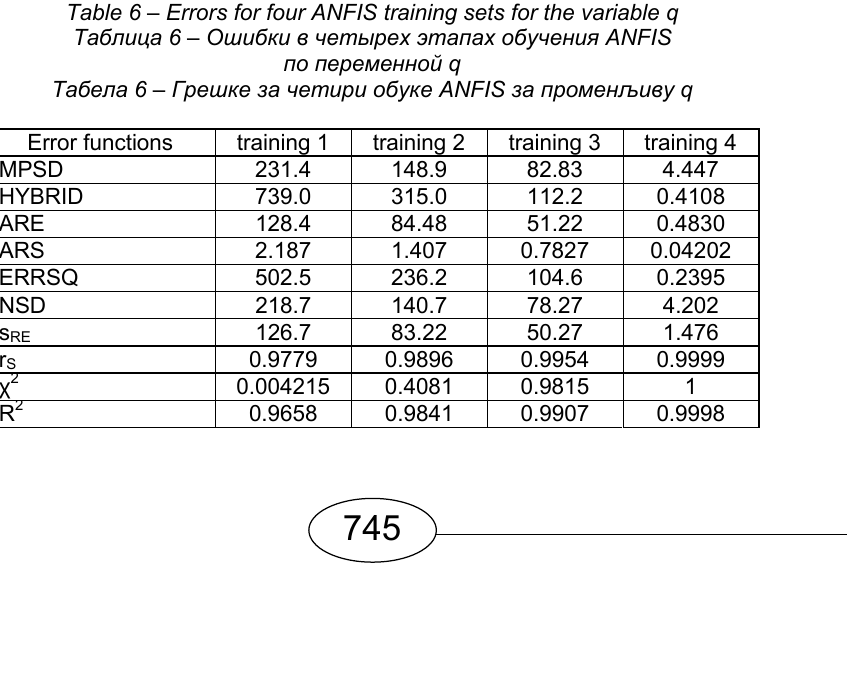
Table 6 – Errors for four ANFIS training sets for the variable